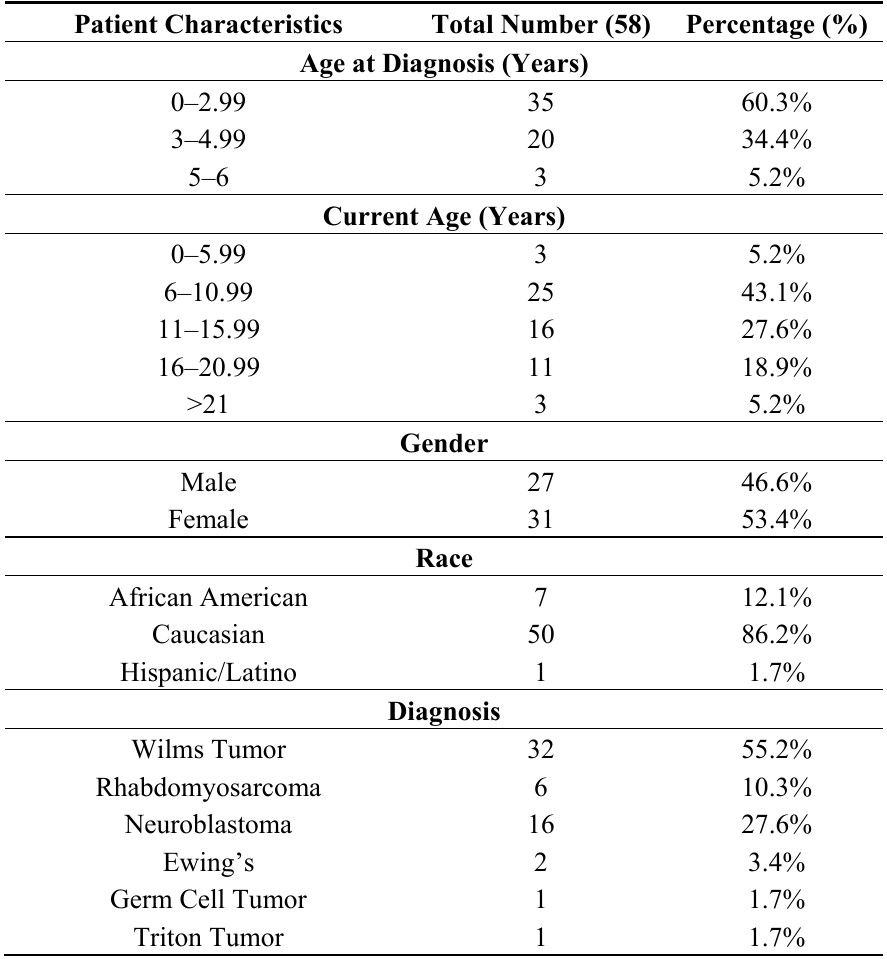
Table 1. Patients’ clinical and demographic